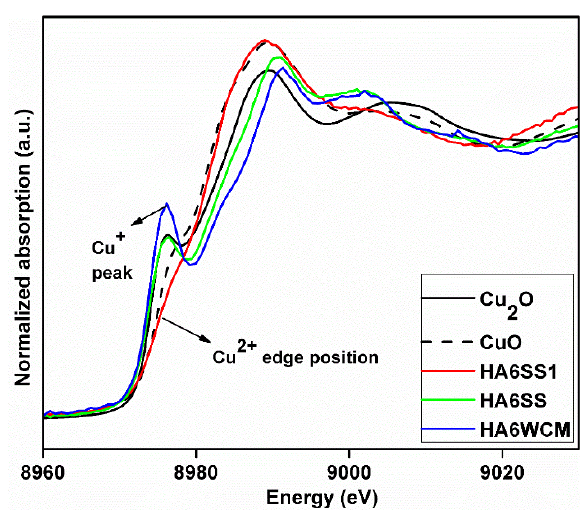
Figure 6. Raman spectra for cupriferous HA systems prepared by the ( a ) solid-state and ( b ) wet chemical synthesis routes.